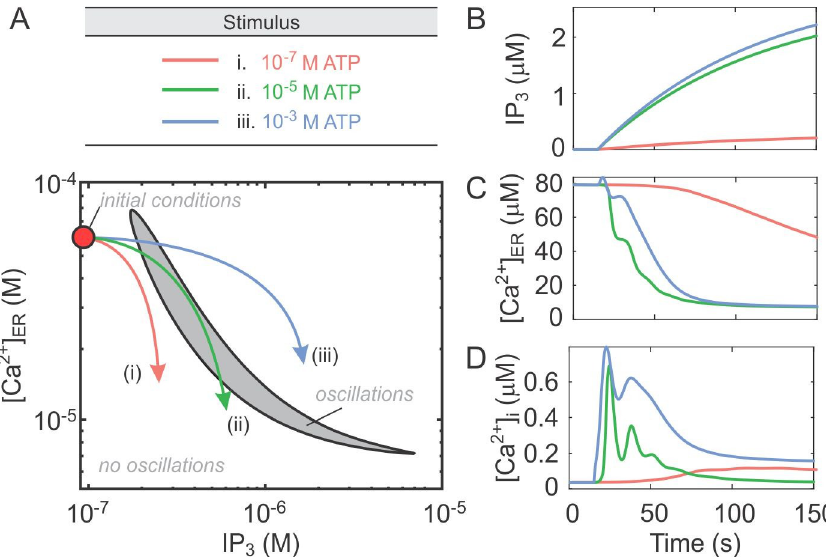
Fig 5. Ca 2+ oscillatory response dynamics defined by the P2Y2-induced changes in [Ca 2+ ] ER and [IP 3 ]. The model defined by Eqs (1)–(3) ,was examined with J = 0. (A) The slow variables representing [IP 3 ] and [Ca 2+ ] ER were set P 2 X 7 R to be independent parameters and the continuation method in XPPATU was applied to track two supercritical Hopf bifurcation points that enclose the oscillatory region ( grey region ). Arrows indicate the three possible scenarios that describe the changes in [IP 3 ] and [Ca 2+ ] ER during Ca 2+ responses: 10 − 7 M ATP response trajectory remains outside the oscillatory region ( red ), 10 − 5 M ATP response trajectory spends an extended period of time inside the oscillatory region ( green ) and 10 − 3 M ATP response trajectory briefly crosses through the oscillatory region ( blue ). (B-D) Simulated changes in IP 3 (B) , [Ca 2+ ] ER (C) and [Ca 2+ ] i (D) following the application of 10 − 7 M ATP ( red ) 10 − 5 M ATP ( green ) or 10 − 3 M ATP ( blue